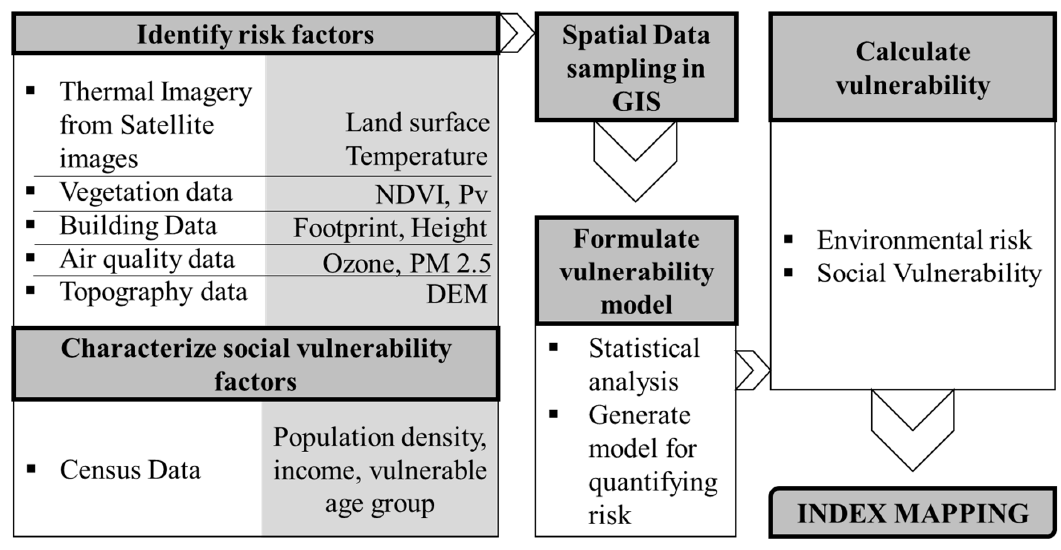
Figure 2. Step-by-step procedure to quantify vulnerability.